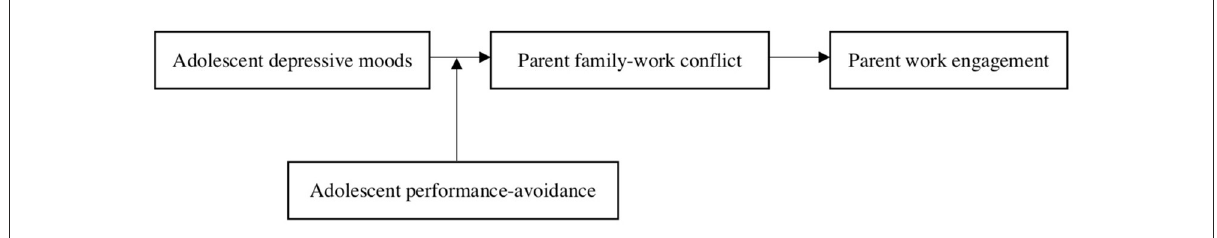
FIGURE1 Theoretical model of adolescents’ depressive moods and parents’ work engagement.